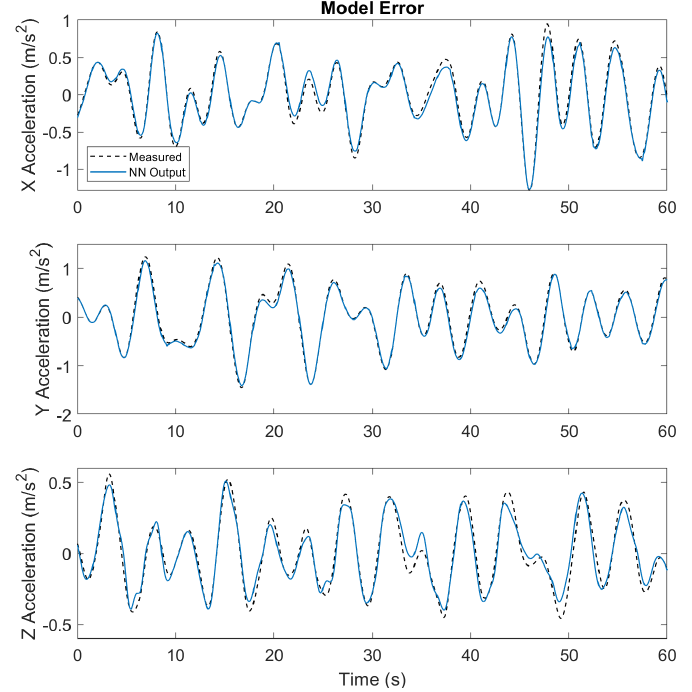
Figure 5. Comparison of neural network model prediction output and measured data for linear accelerations from Gazebo Iris quadrotor